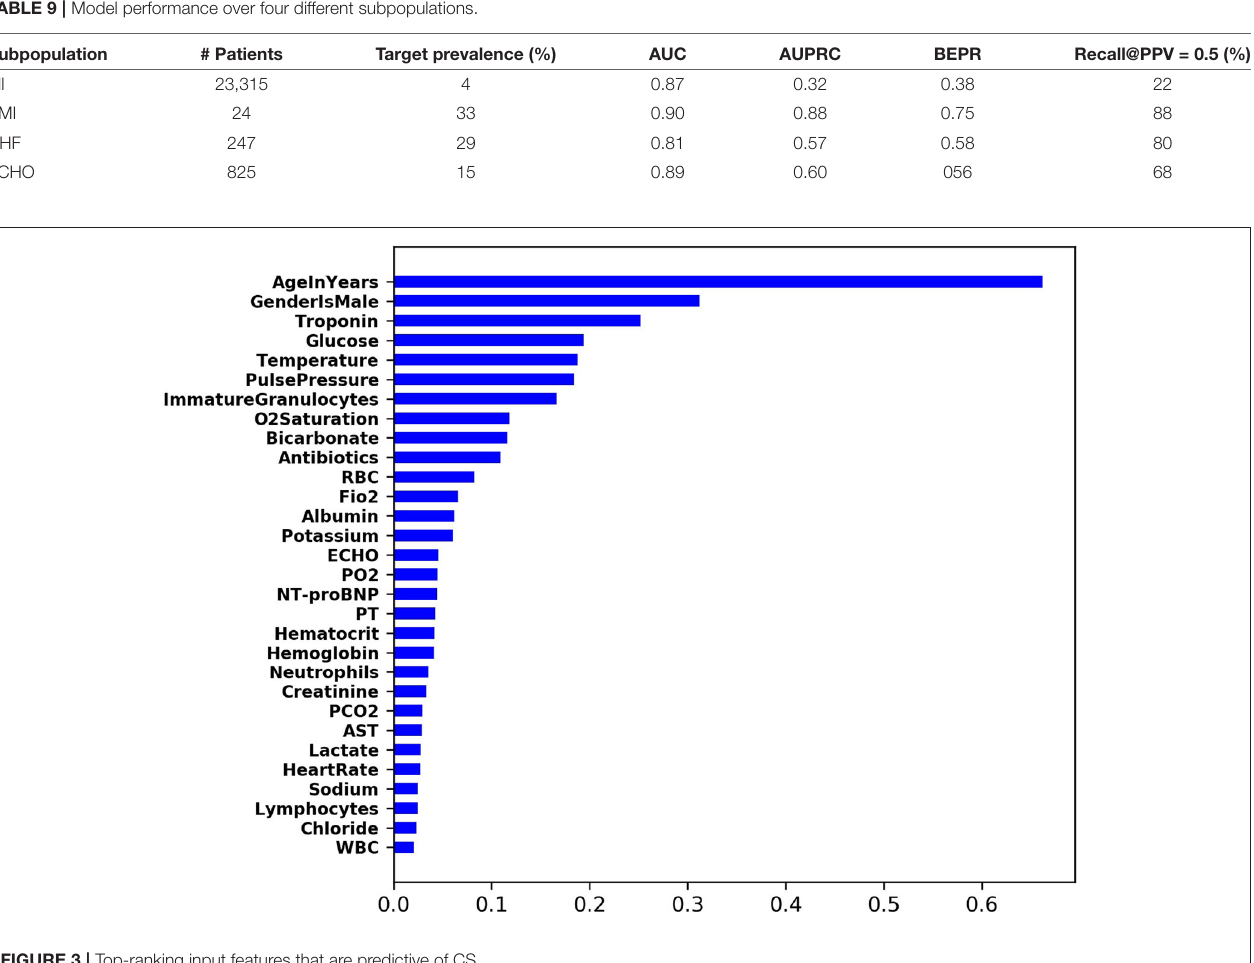
FIGURE 3 | Top-ranking input features that are predictive of